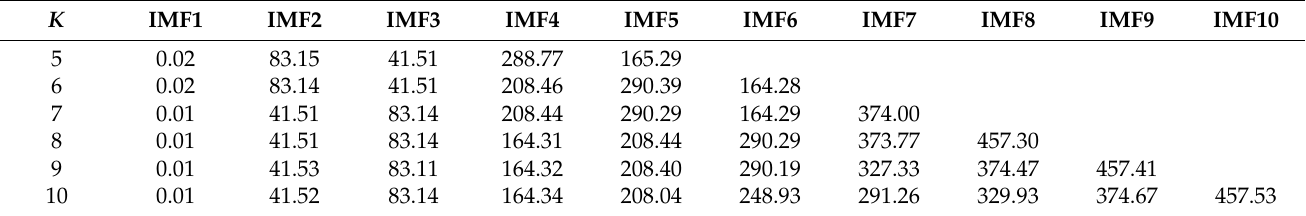
Table 1. The center frequency of each IMF component under different K